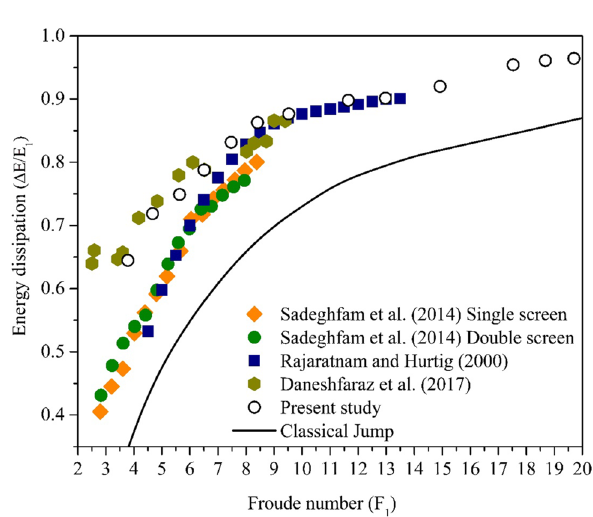
Fig. 9 Screen performance comparison between current and former